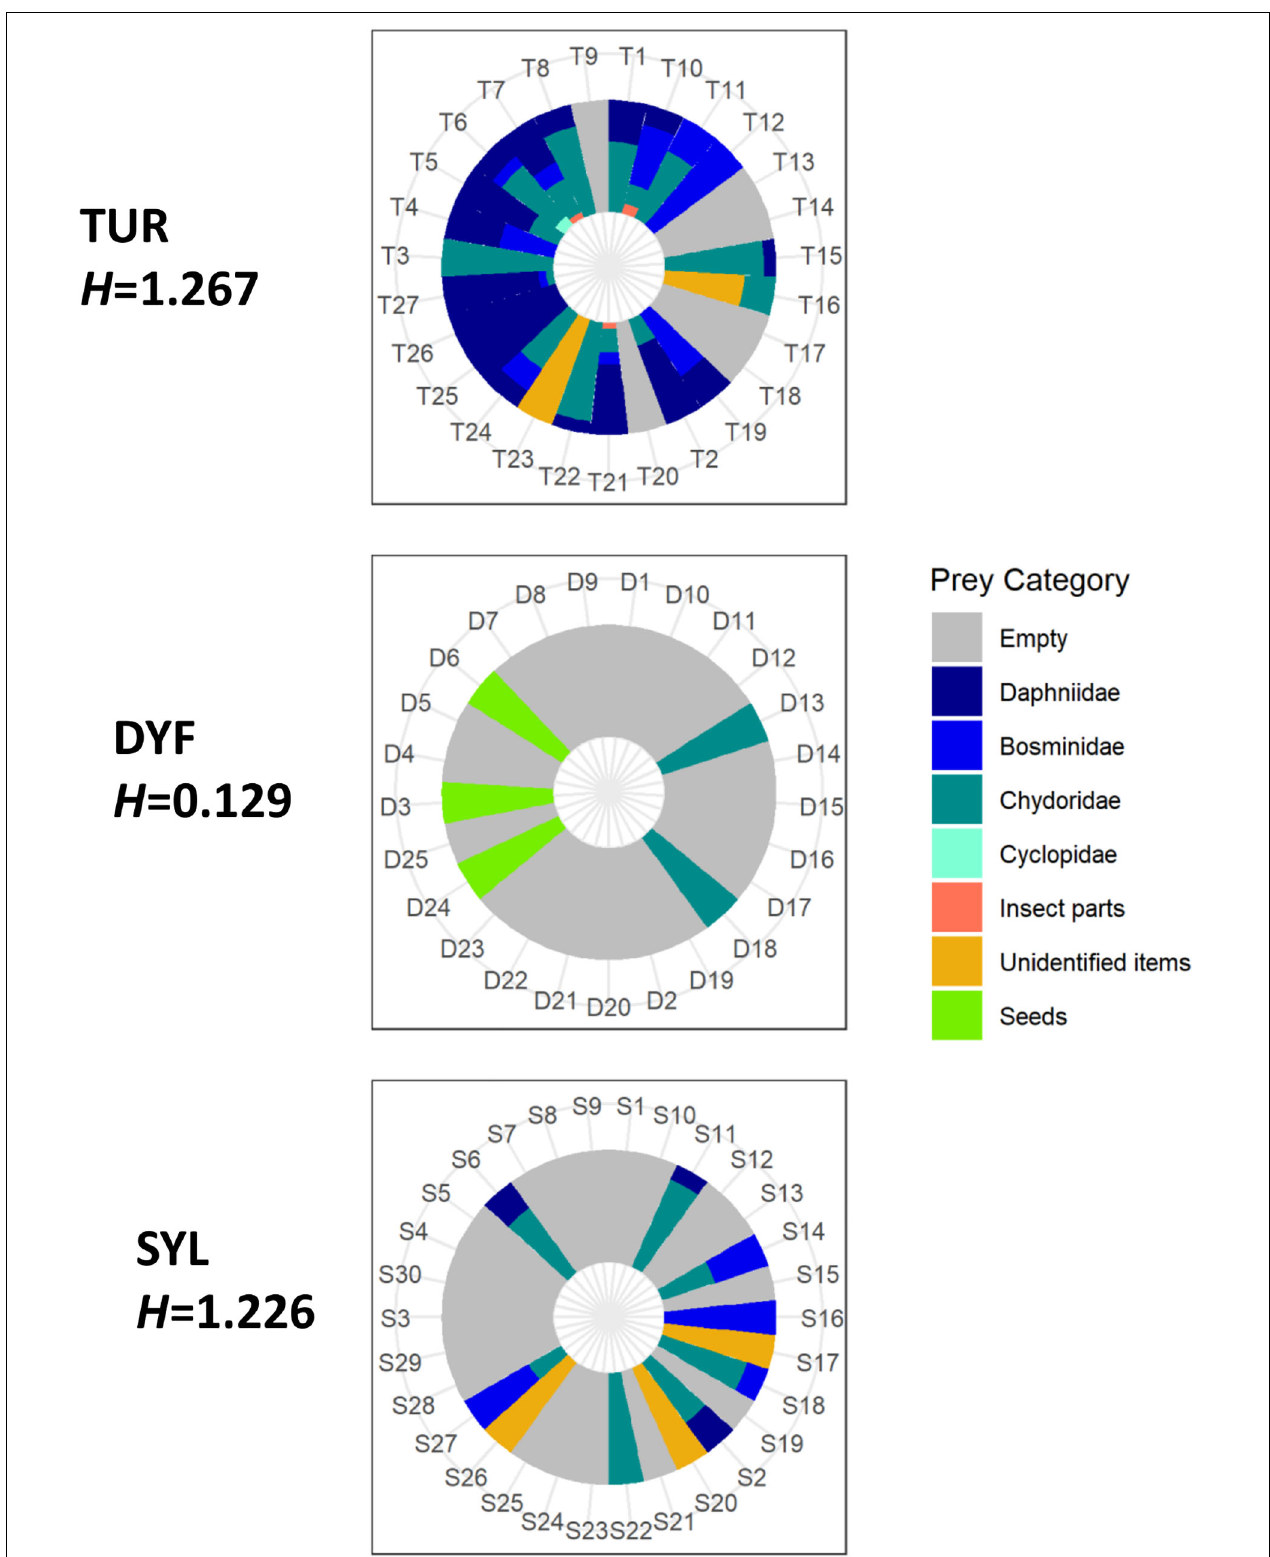
FIGURE 3 | Individual variation in the diet of topmouth gudgeon (% items) across study sites showing Shannon diversity index ( H ). Each numbered sector represents one fish.